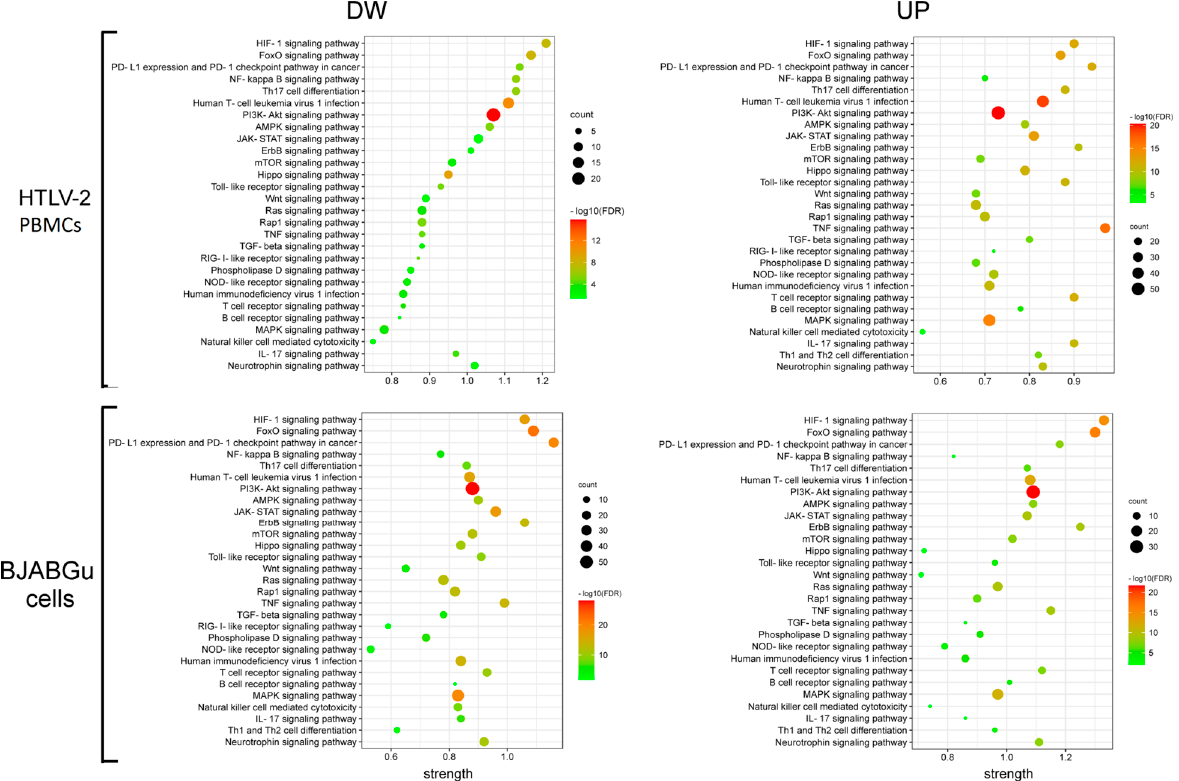
Figure 3. Bubble plot of the KEGG pathway enrichment of the target genes. The strength of the enriched signaling pathways associated with the target genes of the downregulated (DW) miRNAs ( left panel ) and upregulated (UP) miRNAs ( right panel ) in HTLV-2 infected PBMCs ( upper panel ) and BJABGu cells ( bottom panel ). The size and color of each bubble represent the number of target genes in each pathway and its corresponding p -value, respectively.